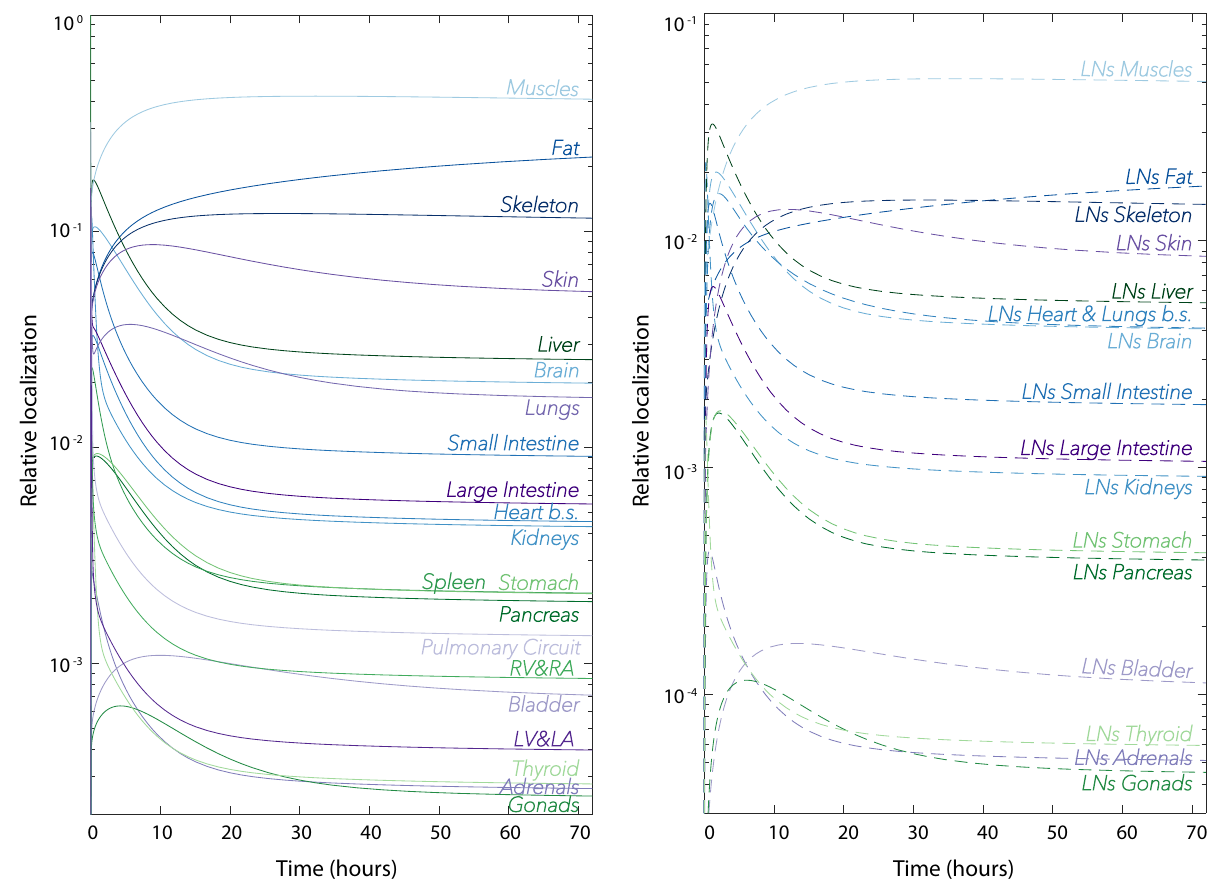
Figure 4. Example results from the ODE system, subject to the initial distribution of T cells administered intravenously (Eq. 4), with baseline parameter values (see Table S.1, Supplementary Material). Each curve represents the sum of the number of T cells in vascular ( N o ) and interstitial localisations ( ˜ N o ) expressed as fraction of the total number of administered T cells (Relative localisation). For all organs (left) and all organ- draining groups of lymph nodes (right), extravasation, e o , and return parameters, µ o , were assumed to be equal to 0.25 and 0.05, respectively. Note that the contents of heart chambers ( RA&RV and LA&LV ) and the blood supply to the heart (Heart blood supply) are plotted separately. Similarly, the lung curve does not include the pulmonary